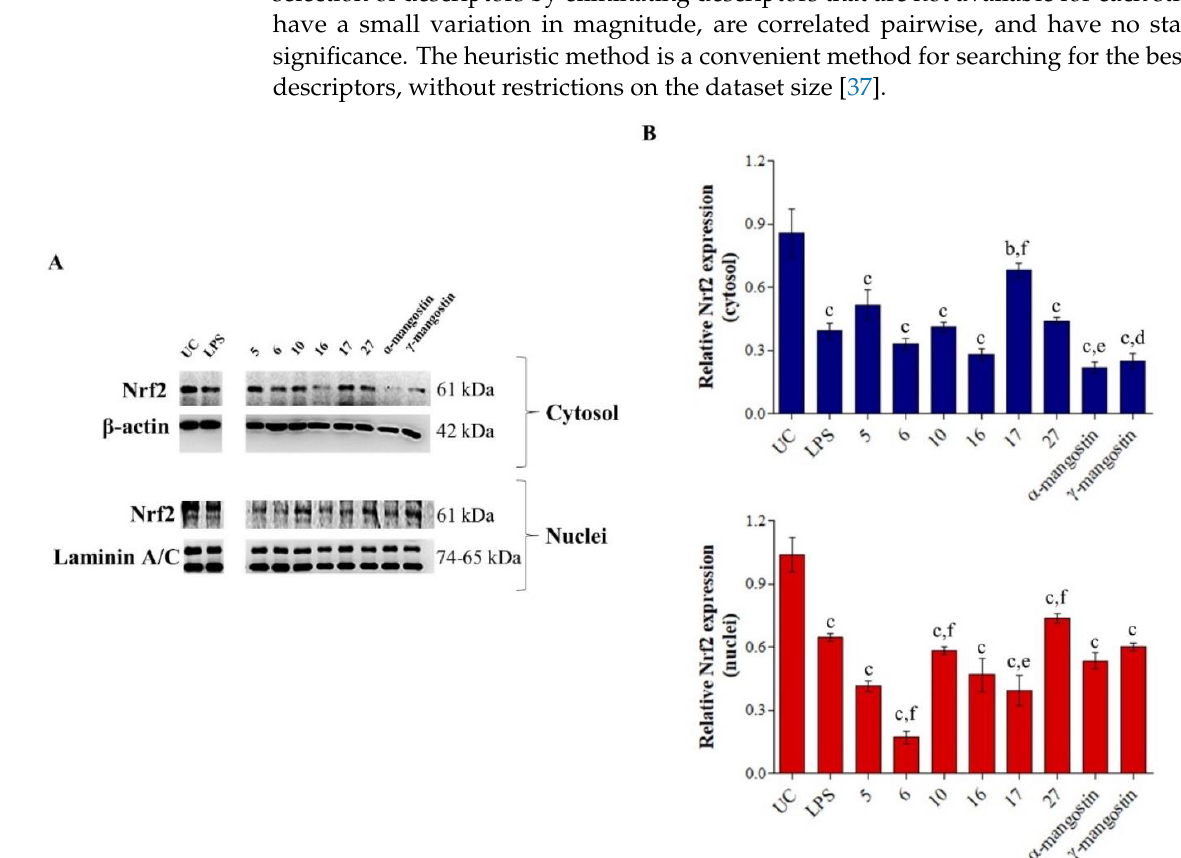
Figure 2. Nrf2 protein expression in cytosols and nuclei of inflamed macrophages in the presence of compounds 5 , 6 , 10 , 16 , 17 , 27 , and mangostins after 24 h of exposure. ( A ) Western blot analysis of Nrf2 in cytosolic and nucleic protein fractions. β -actin and laminin A/C were used as loading controls. ( B ) Bar graphs display densitometric values normalized using the loading controls. UC = untreated cells (cells pre-incubated with BSO for 18 h). LPS = cells stimulated with 0.5 µg/mL LPS alone. b = p < 0.001 and c = p < 0.0001 between samples and UC; d = p < 0.01, e = p < 0.001, and f = p < 0.0001 between samples and LPS.